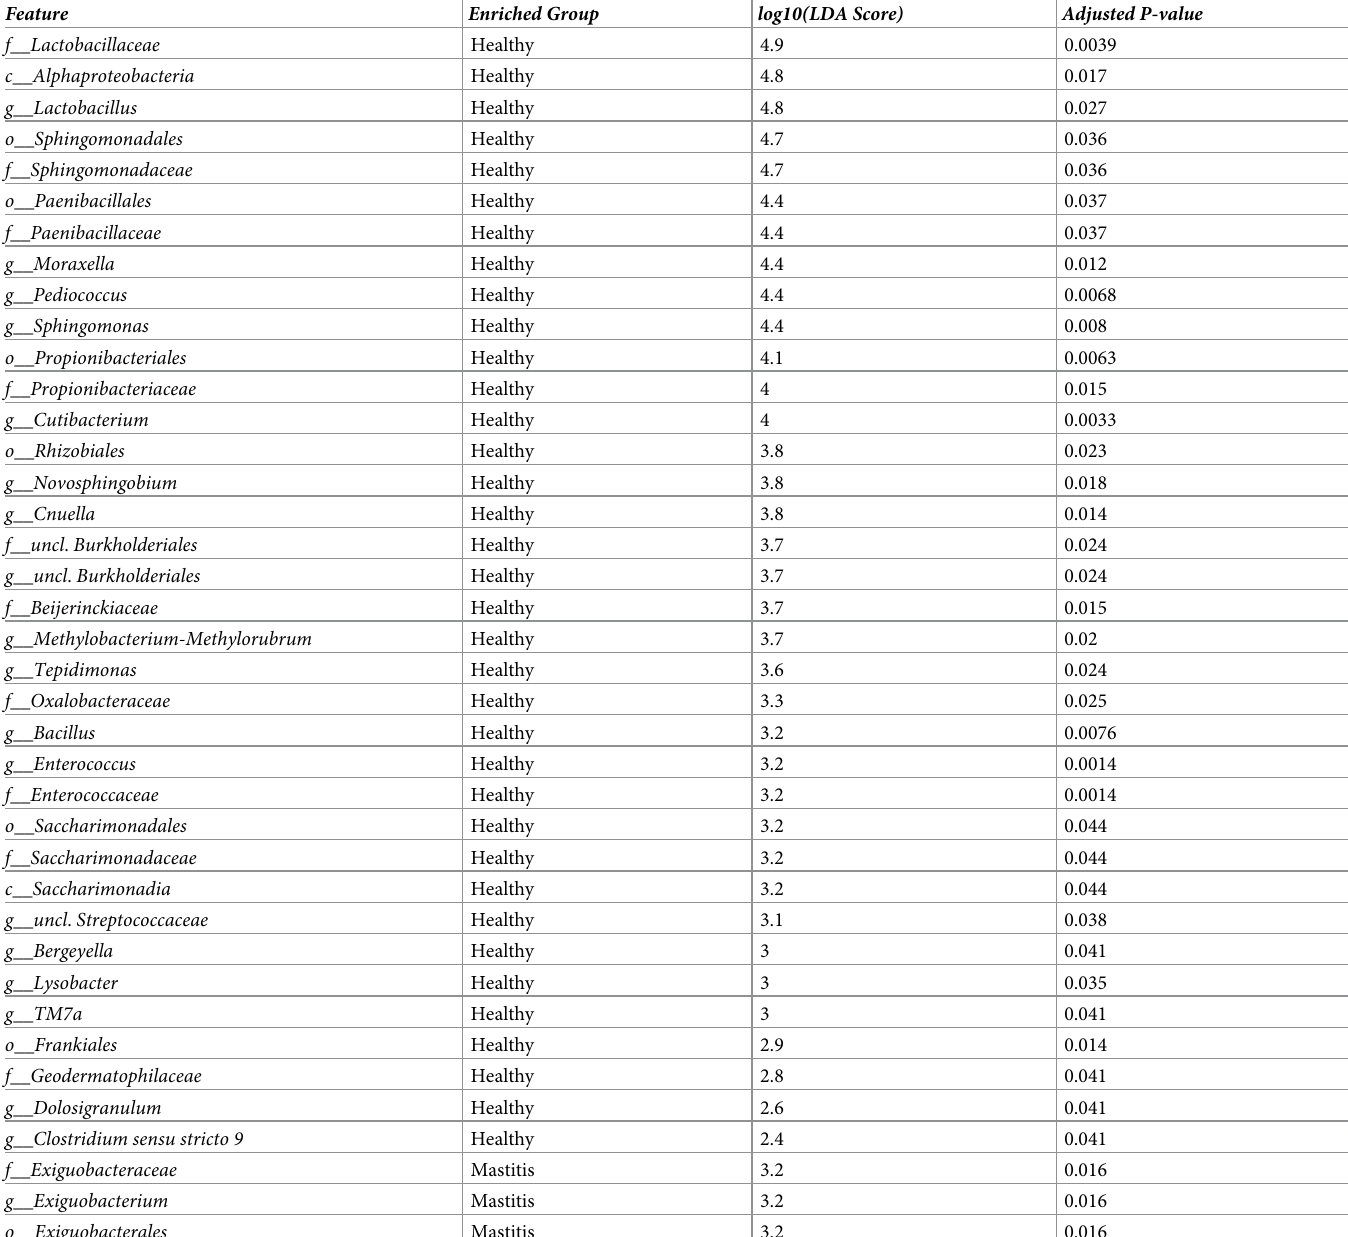
Table 3. Lefse marker table at taxonomic level for healthy and mastitis samples for 16S